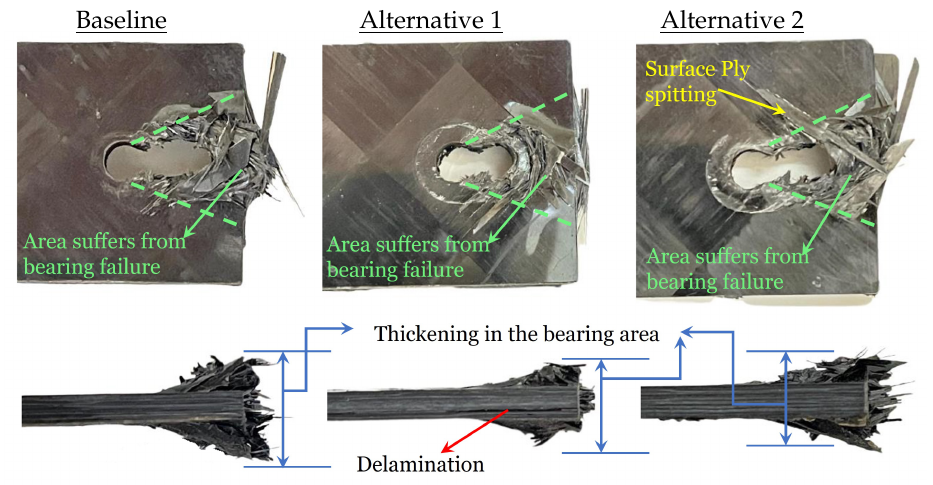
Figure 6. Examples of the failure mode associated by the three configurations.